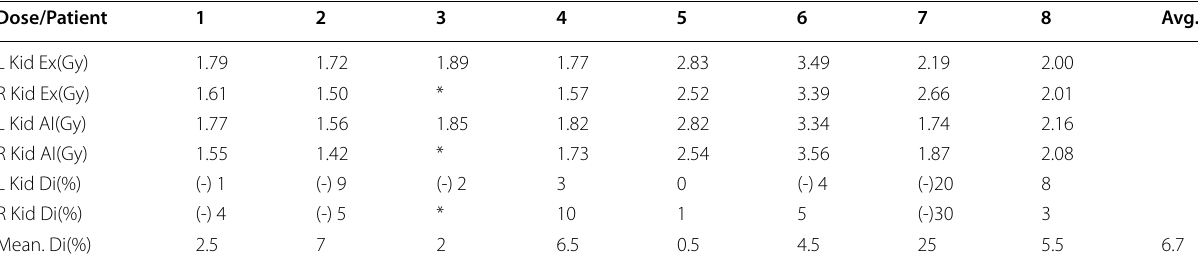
Table 4 The calculated mean absorbed dose (Gy) deposited to the left and right kidneys resulted from application of the AI segmentation (labelled with “AI”) and the dose calculations performed by the experts (labelled with “Ex”) Dose/Patient